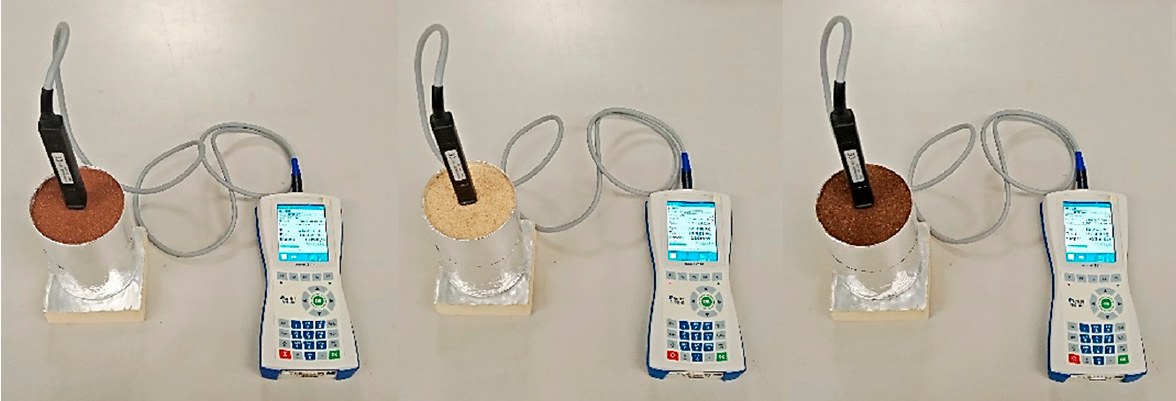
Figure 1. Photographs of raw materials: ( a ) red clay; ( b ) sawdust; ( c ) coconut coir dust.